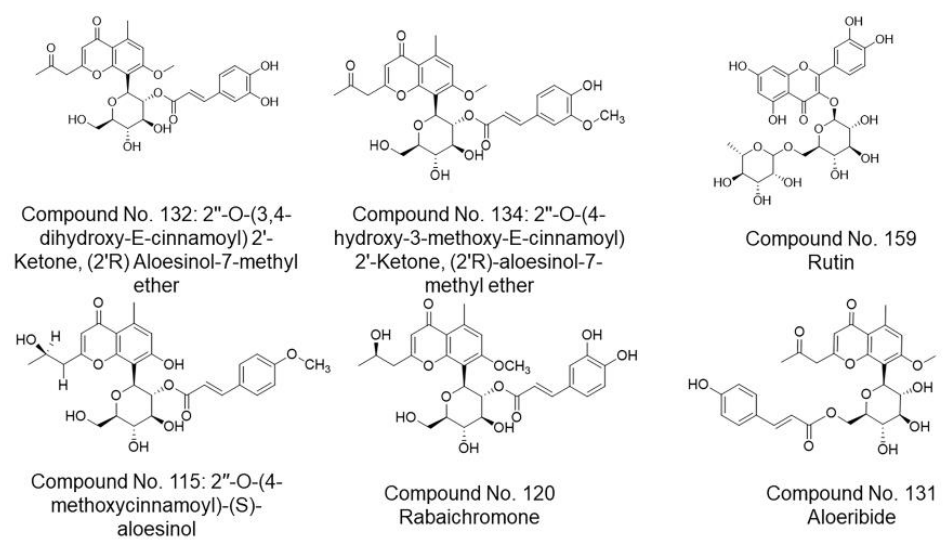
Figure 4. Docking scores and RMSD values of isolated compounds from Aloe genus against SARS- CoV-2 spike glycoprotein.